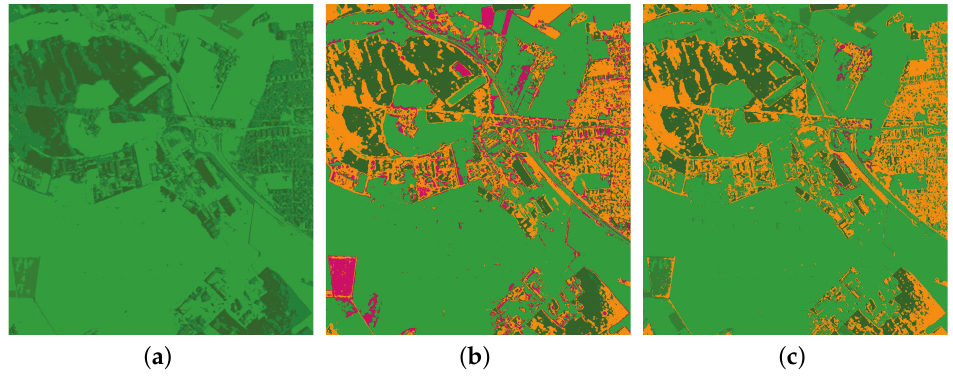
Figure A2. The relative change rate of the whole image and image blocks.